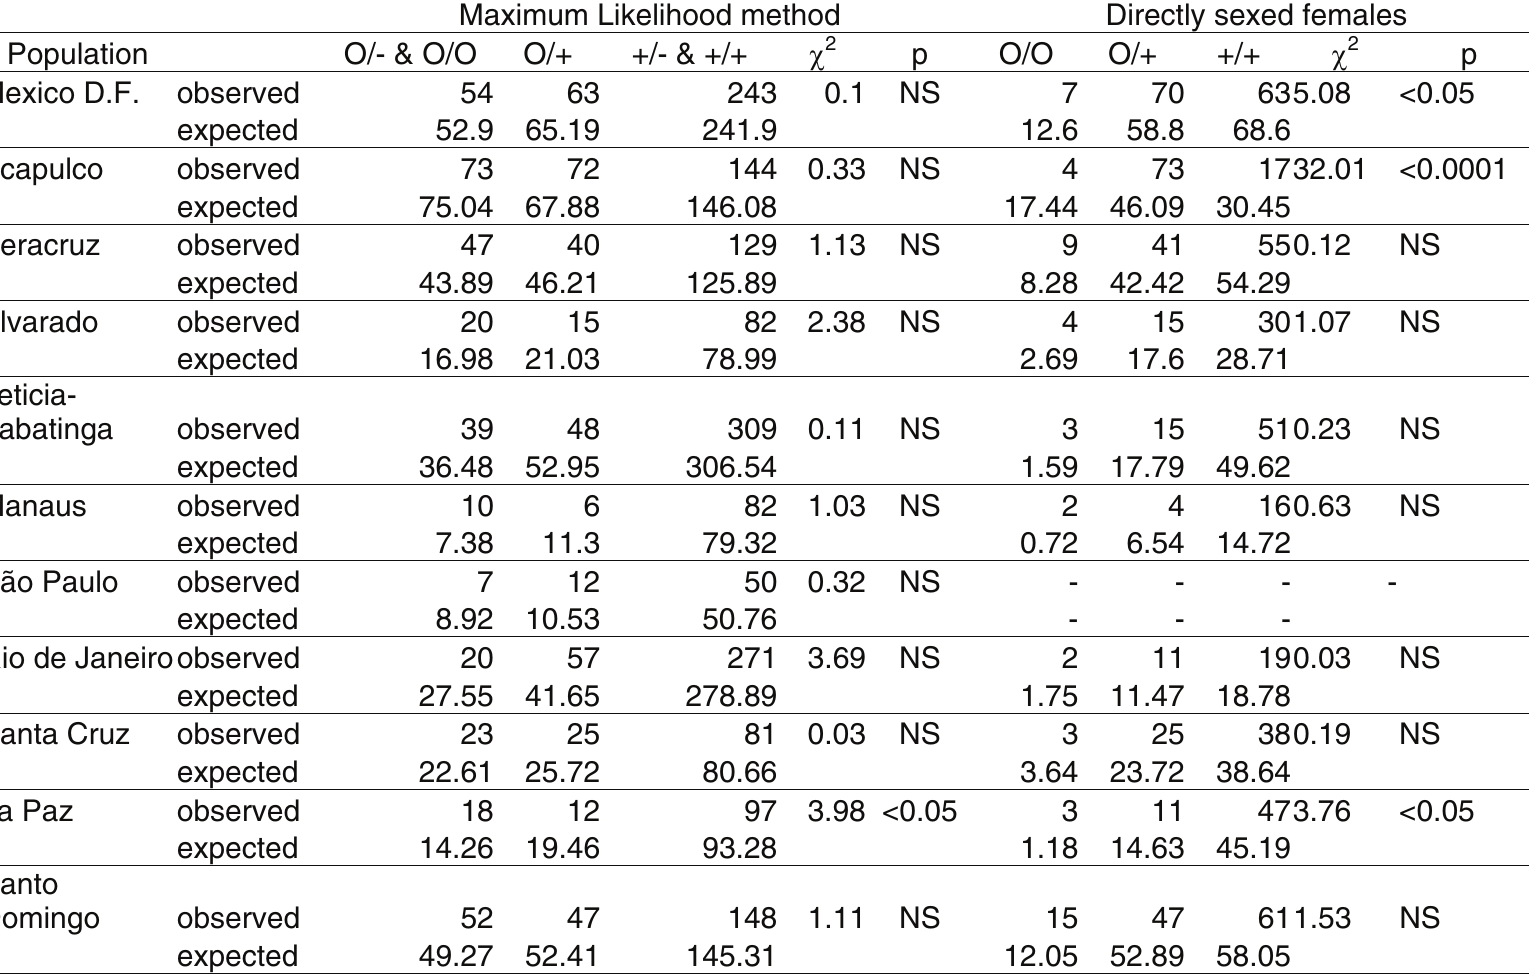
Table S2. Hardy-Weinberg analysis applied to the Orange ( O ) locus using a Maximum likelihood method, with the females directly sexed in the 11 Latin American cat populations. O/- = Orange males; O/O = Orange females; O/+ = calico (= heterozygote) females; +/- = wild males; +/+ = wild females; Χ 2 = chi-square test; P = probability; - = not